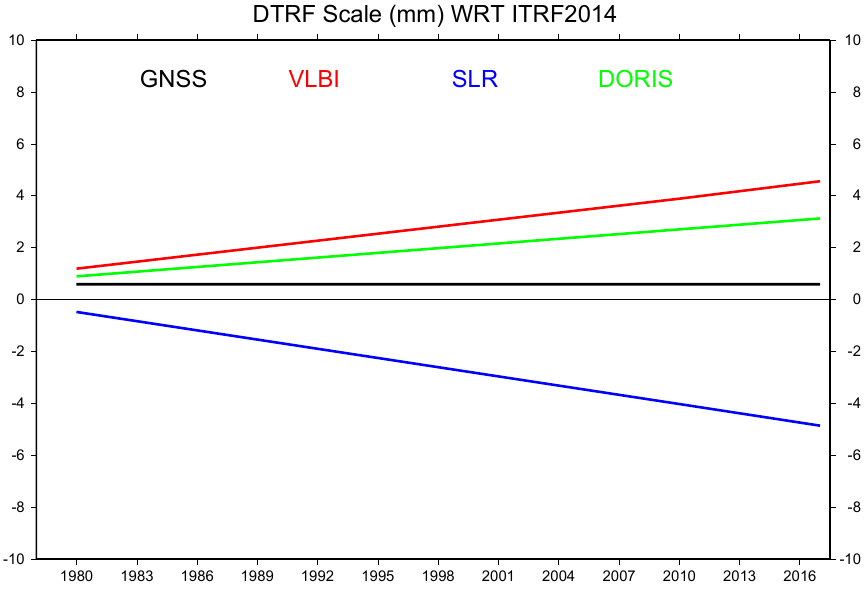
Figure 1. DTRF2014 scale with respect to